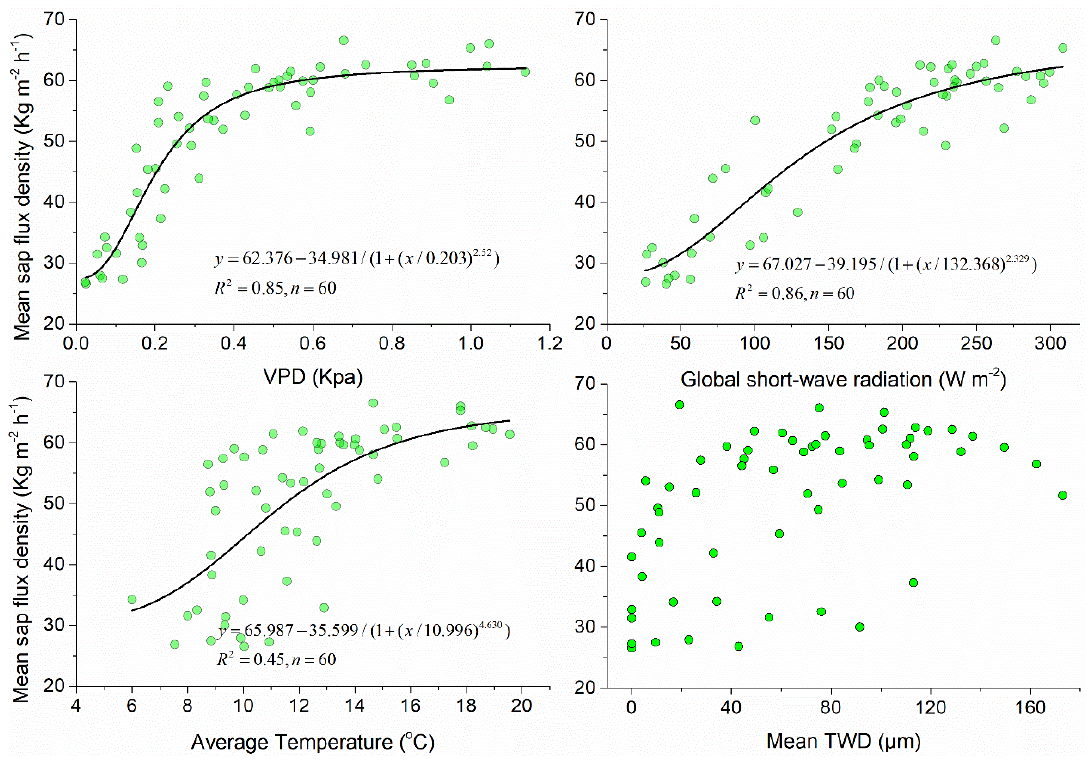
Figure 6. Relationships between sap flux density and vapor pressure deficit (VPD), global short-wave radiation, average air temperature, and daily tree water deficit (TWD) for the treatment group over the growing season.